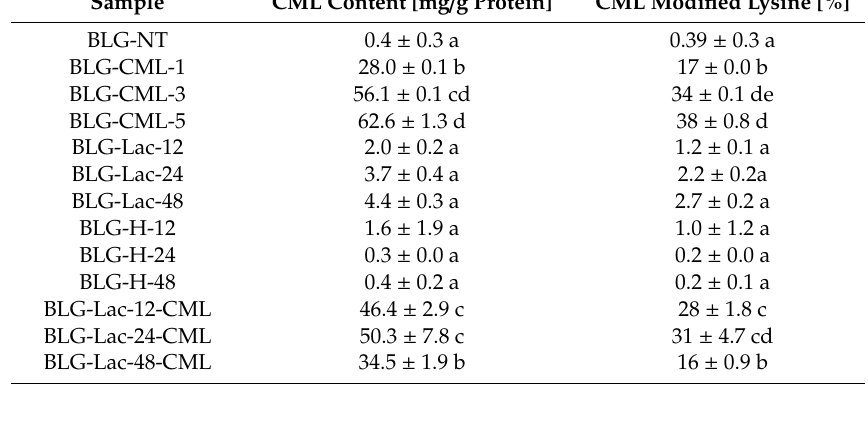
Table 1. CML content of di ff erentially treated β -lactoglobulin (BLG). BLG was non-treated (NT), chemically modified with glyoxal to obtain N ε -carboxymethyl lysine (CML) at di ff erent degree of modification (1, 3, and 5), glycated with lactose (Lac) by heating at 60 ◦ C for 12, 24, and 48 h; heated at 60 ◦ C for 12, 24, and 48 h in the absence of any sugars (H), and glycated by heating with lactose followed by CML induction with glyoxal. CML modified lysine was calculated based on theoretical levels of lysine available in BLG. Results are given as mean ± standard deviation ( n = 2). Statistical di ff erences were tested using one-way ANOVA with Tukey post-hoc test. Significant di ff erences are considered at p < 0.05, where two variables have di ff erent letters if they are significantly di ff erent. Sample CML Content [mg / g Protein] CML Modified Lysine [%] BLG-NT